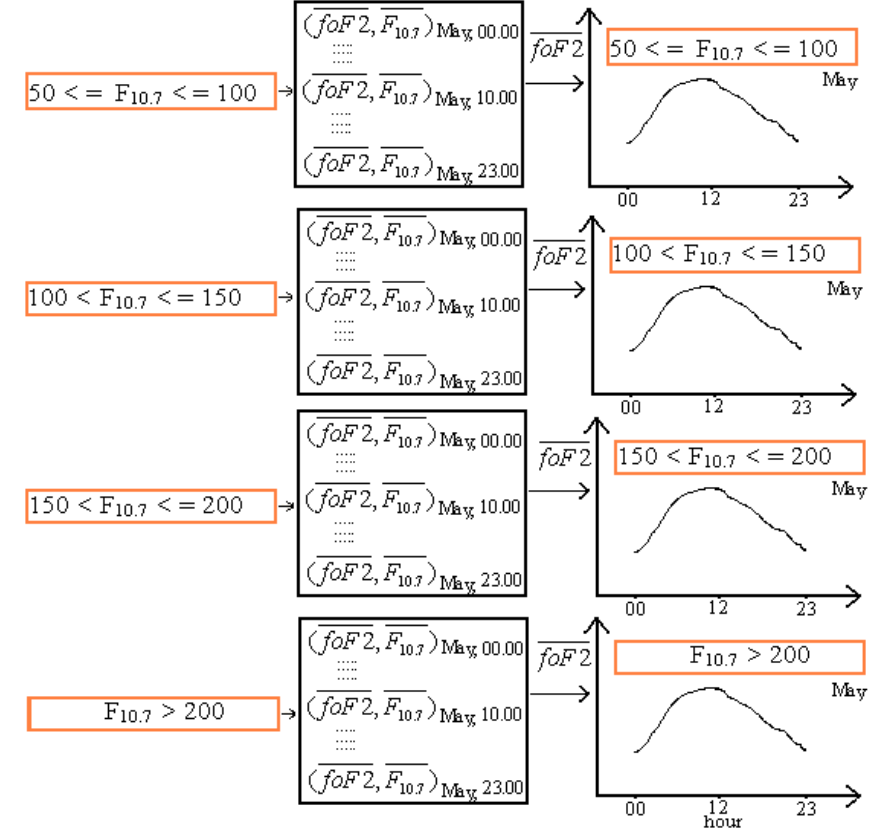
Fig. 3. Scheme followed to obtain the quiet-time fo F2 profiles from each range of solar flux selected for a given month (May).